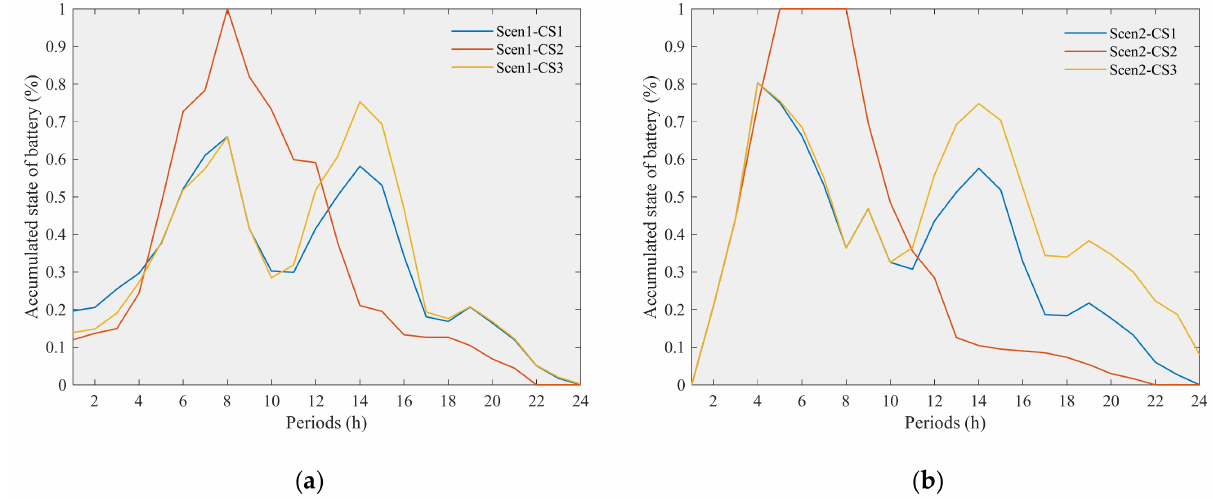
Figure 11. Accumulated state of the battery, ( a ) without wholesale participation and ( b ) with wholesale participation. In Scen1-CS2 at 8:00, the community members have the batteries at the maximum level of capacity, the same happens in Scen2-CS2 for periods 5:00 to 8:00. The identified scenarios are both UPP facilities. Figure 11b presents the state of the batteries but considering the possibility of the wholesale transaction and in the case of Scen2-CS2 the full state of batteries is obtained when the purchases in the wholesale market occur (Figure 11b).